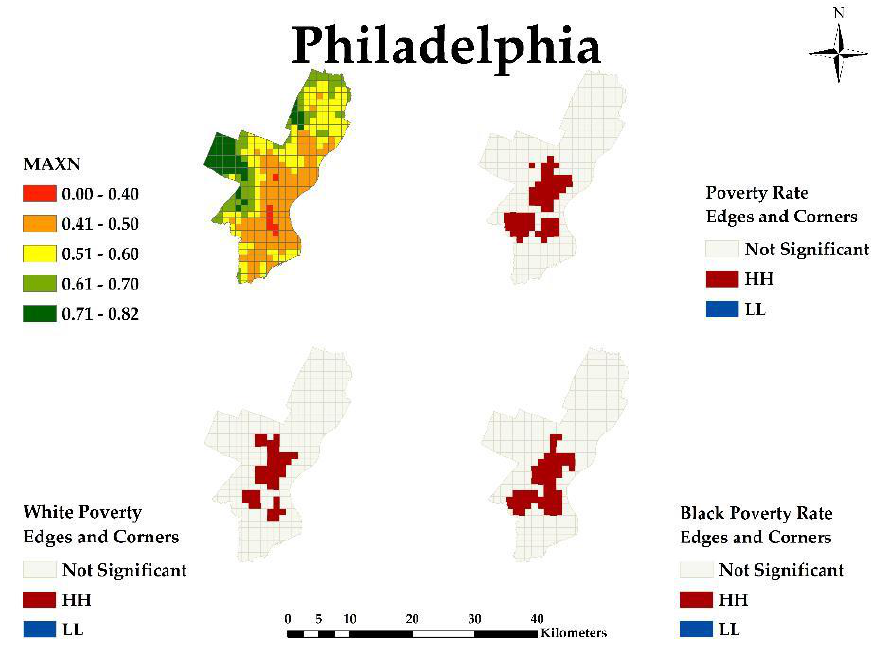
Figure 4. The LISA maps of Philadelphia shrinking city: MAXN, Poverty Rate, White Poverty Rate, and Black Poverty Rate.